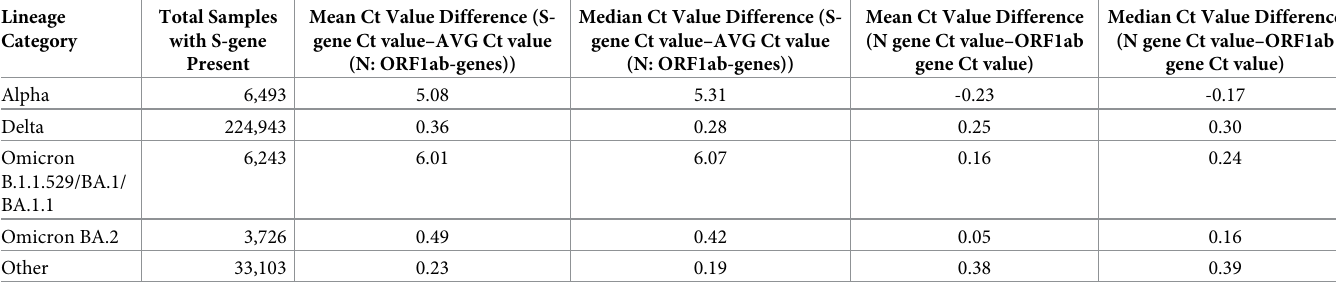
Table 2. Ct value differences in WGS confirmed lineages with S-gene